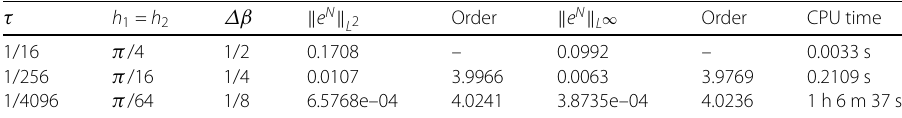
Table 7 Errors and convergence orders of scheme (62)–(64) with an optimal step size ratio for τ , h 1 , h 2 , h 3 and Δβ (Example 2)